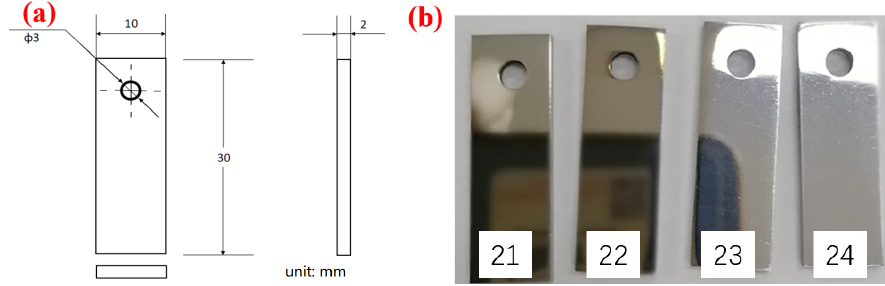
Figure 1. Specimens for the corrosion experiment : ( a ) sample processing size; ( b ) specimen macro- scopic image and the sample number on the test specimens with number.